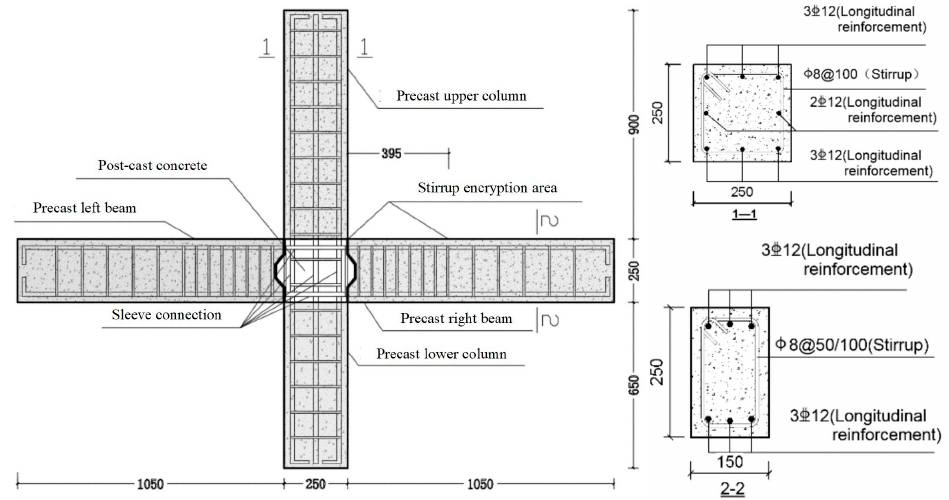
Figure 1. Dimensions and reinforcement of the beam-column joints/mm.